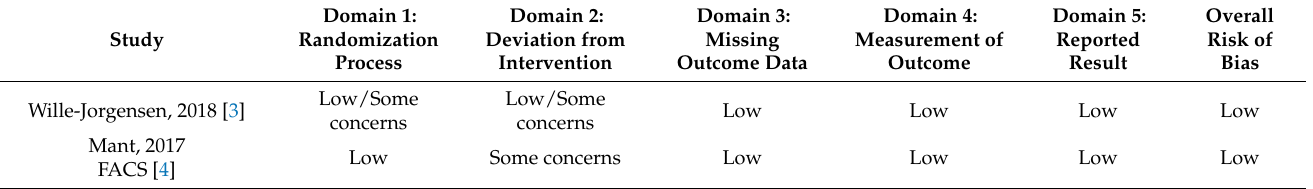
Table A4. Risk of bias,